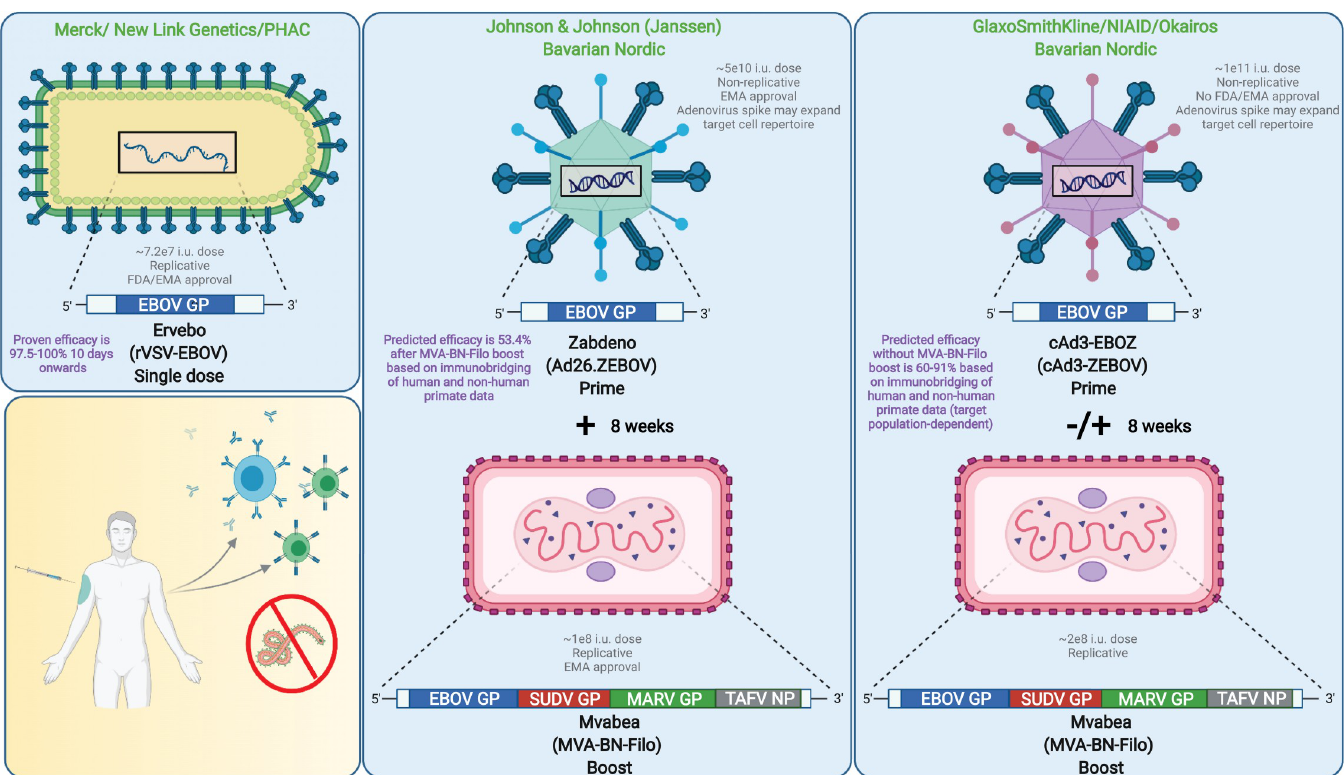
Fig 1. Leading EBOV vaccines. The most advanced vaccines in the US and Europe include Ervebo (rVSV-EBOV), Zabdeno/Mvabea (Ad26-ZEBOV/MVA-BN-Filo), and cAd3-EBOZ (with or without MVA-BN-Filo). These platforms use a viral vector to provoke an immune response, but, as illustrated, there are several distinctions among these 3 vaccines including vector virus, dose, efficacy, cell targets, and inclusion of a booster. Created with BioRender.com. Ad26 AU : TheabbreviationlistinFig 1 hasbeenupdated : Pleaseverifythatallentriesarecorrect : , human adenovirus serotype 26; cAd3, chimpanzee adenovirus serotype 3; EBOV, Ebola virus ( Zaire ebolavirus ); EBOZ, Ebolavirus-Zaire species; EMA, European Medicines Agency; FDA, US Federal Drug Administration; GP, glycoprotein; i.u., infectious unit; MARV, Marburg virus; NIAID, National Immunology Allergy and Infectious Disease; NP, nucleoprotein; PHAC, Public Health Agency of Canada; rVSV, recombinant vesicular stomatitis virus; SUDV, Sudan virus; TAFV, Ta ï Forest virus; ZEBOV, Zaire